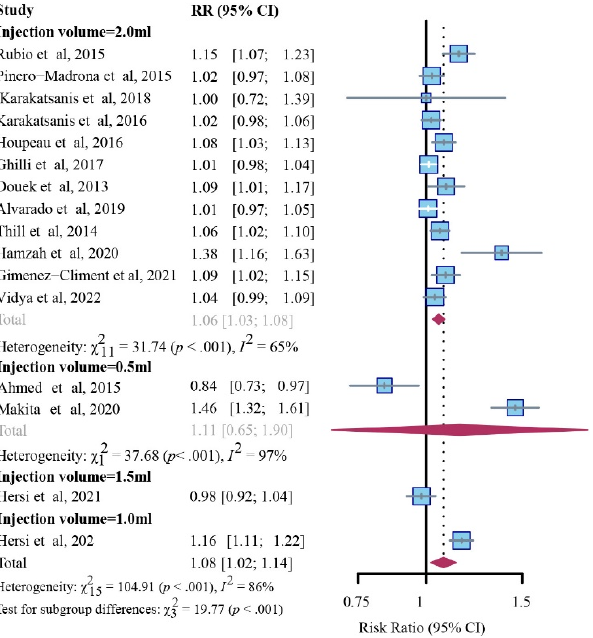
Figure 4. Relative risk (RR) analysis of SLN identification rates for SPIO versus standard method (random-effects model).